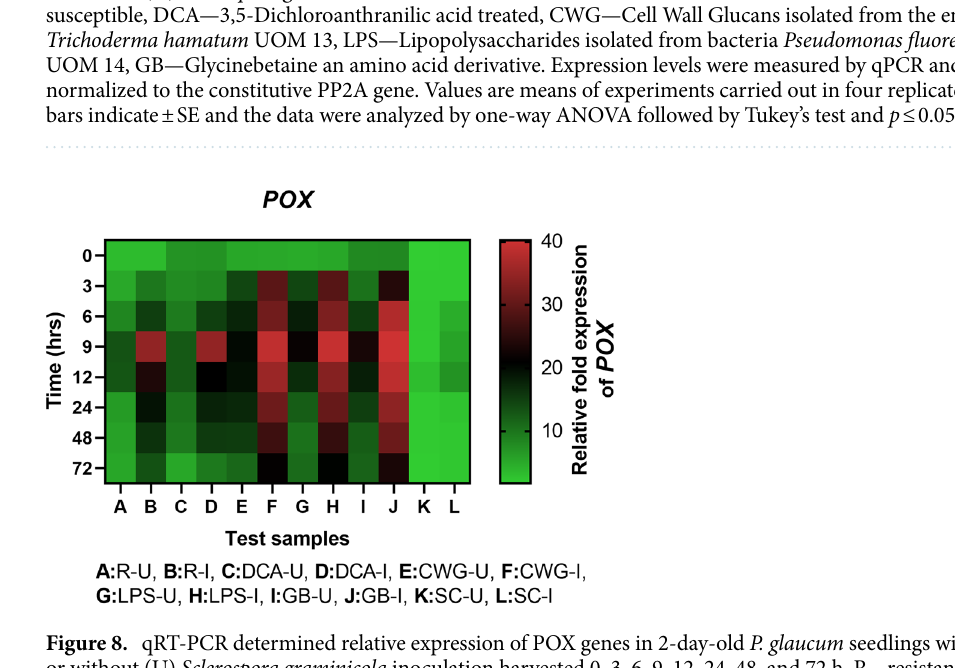
glucanase gene expression was observed in GB treated seedlings followed by LPS, CWG and DCA treatments.